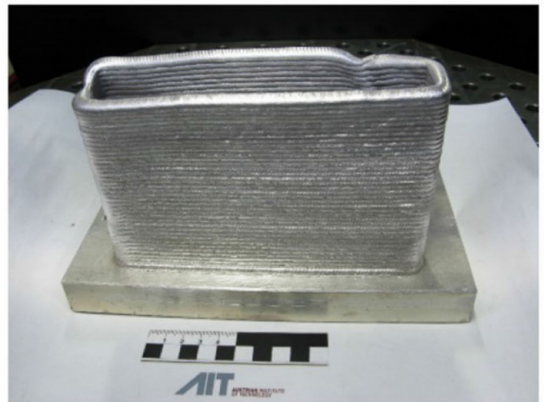
Figure 24. One magnesium (AZ61A) sample fabricated by WAAM